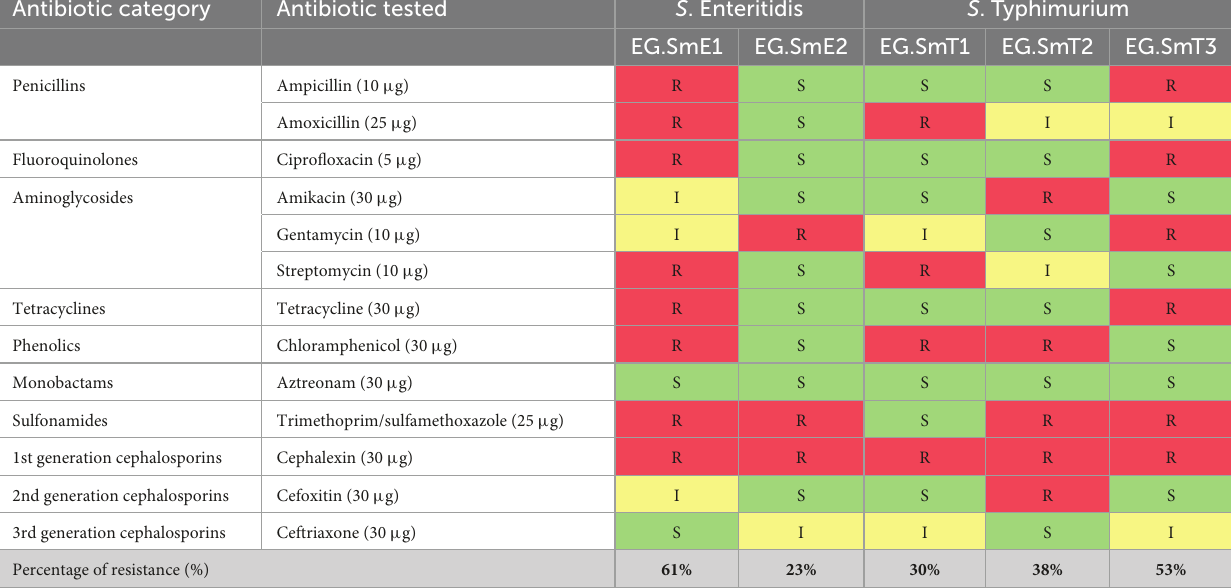
TABLE 1 Antibiotic susceptibility pattern of five Salmonella enterica serovars against a selection of thirteen antibiotics. Antibiotic category Antibiotic tested